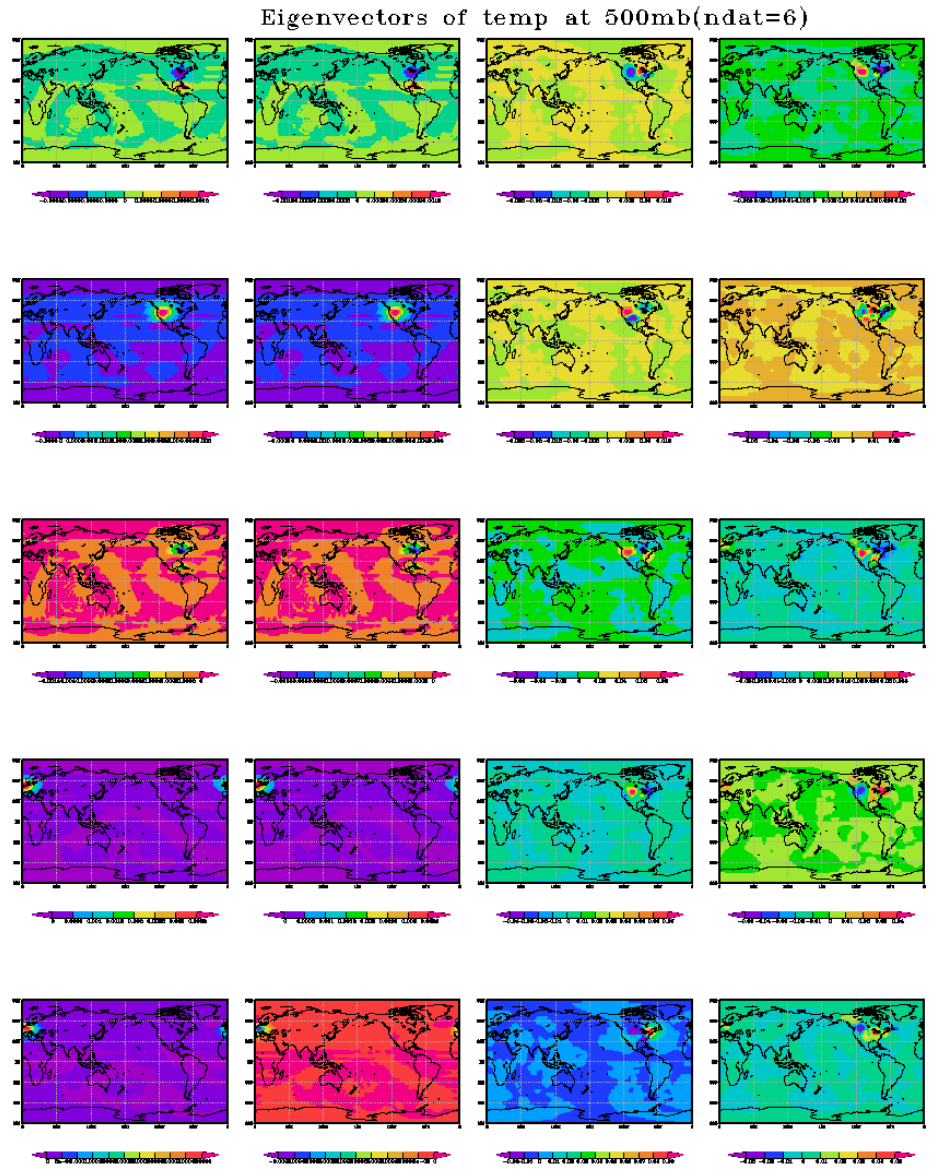
Fig. 3. Top five normalized eigenvectors of the transformed Hessian with respect to temperature at 500hPa with ndat = 6. From the left to the right on each row: top eigenvectors for K = 30 , 60 , 100 , and 116. Top to the bottom on each column: eigenvectors 1, 2, 3, 4, and 5 for each value of K